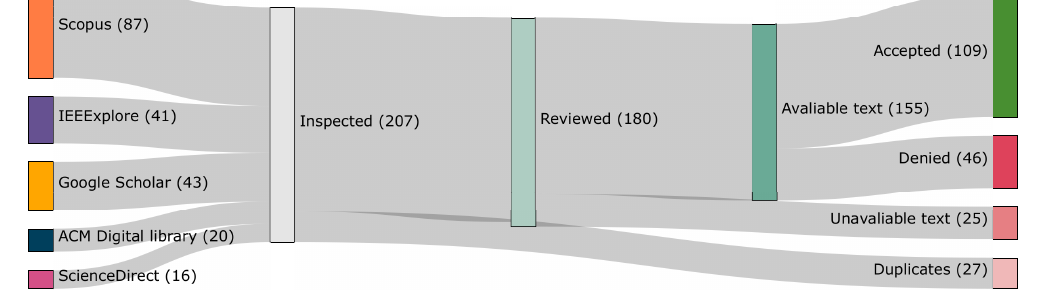
Figure 2. Review